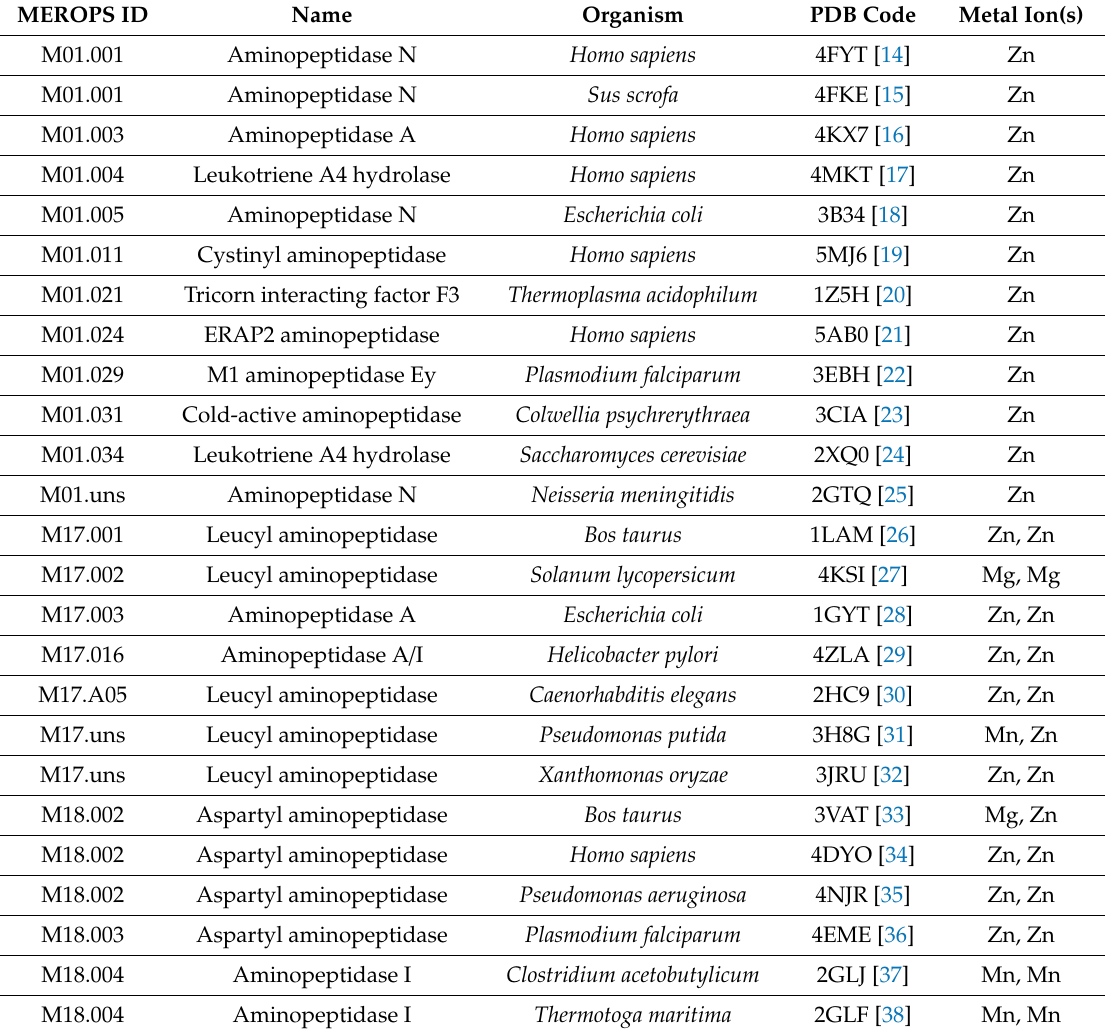
Table 1. Using options implemented in Protein Preparation Wizard the structures were prepared for calculation: all of the water molecules and the ligands were removed, and the proteins were protonated at the experimental pH [13]. Table 1. Metallo-aminopeptidases included in the MEROPS database and selected for this study; the originating organisms and the crystal structures are referenced. PDB, Protein Data